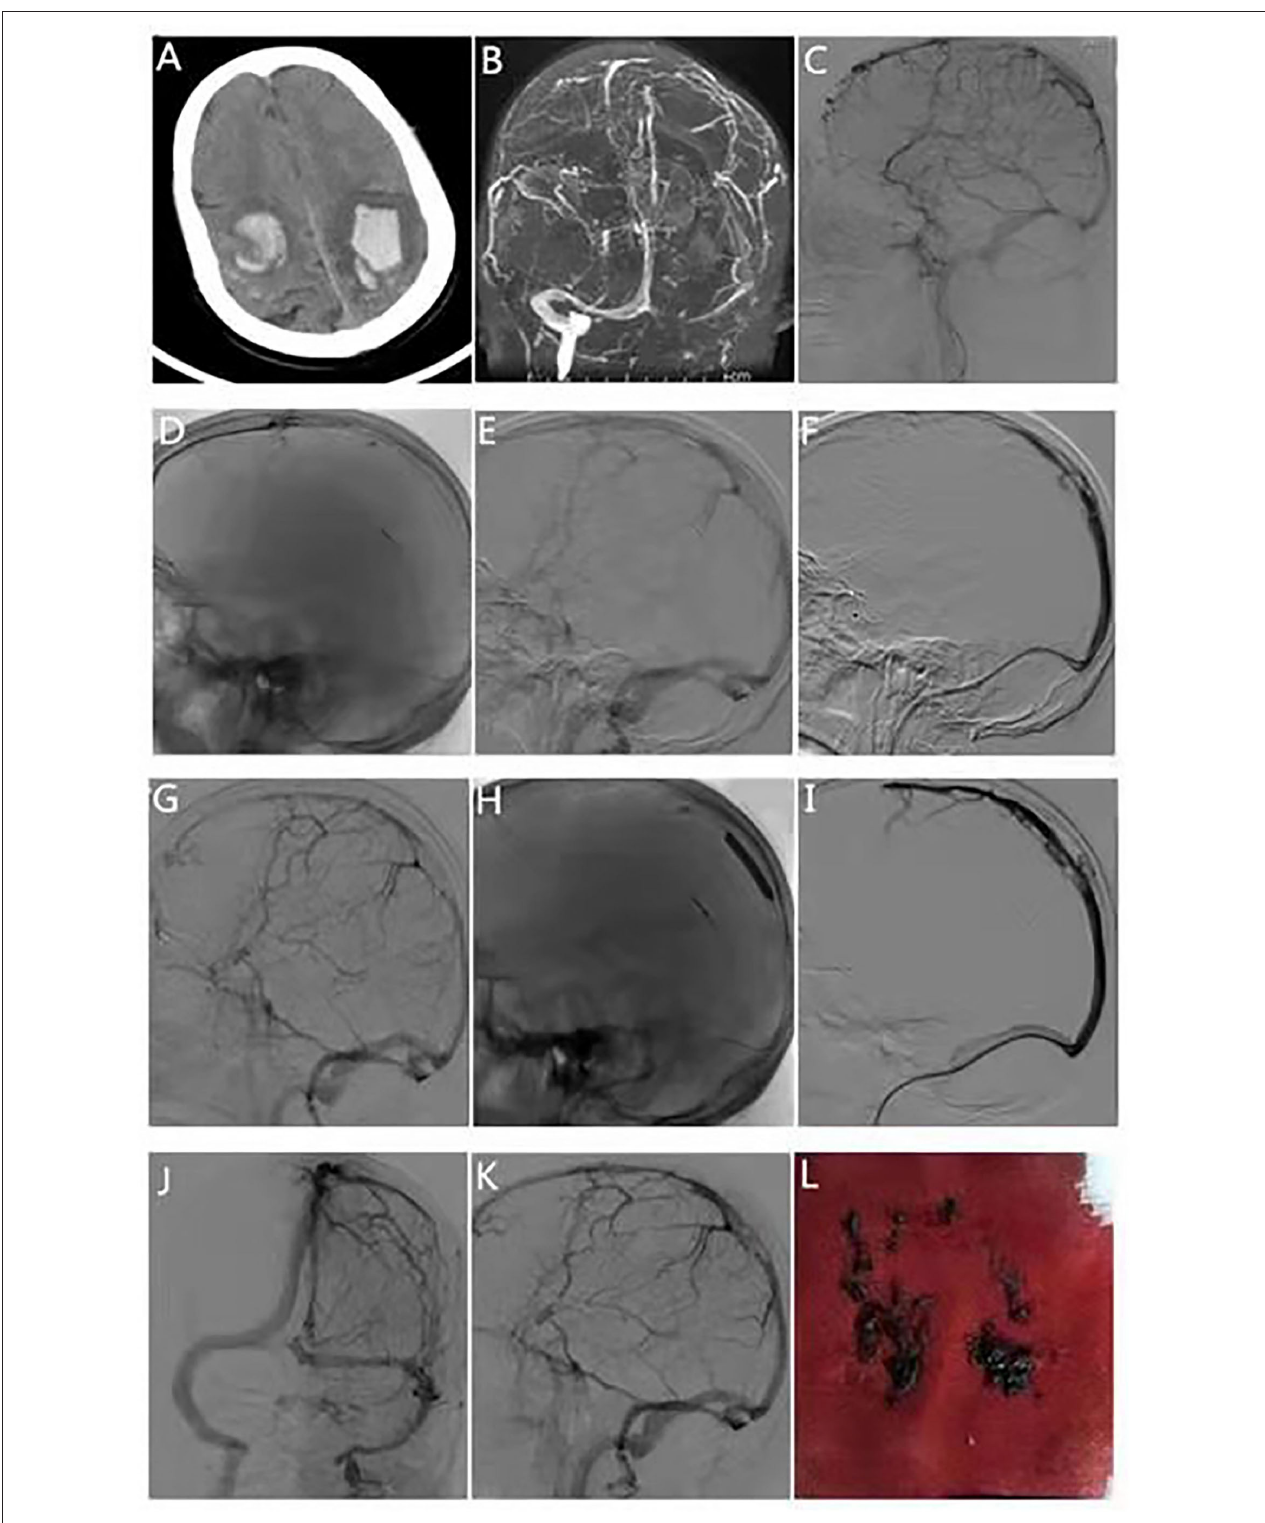
FIGURE 1 | Typical case 1. The patient was a 66-year-old man, transferred from the outside hospital due to sudden unconsciousness, limb weakness, and episodic limb convulsions for 5 days. (A) Head computed tomography scan at the time of transfer shows bilateral parietal hemorrhage. (B) Magnetic resonance venography